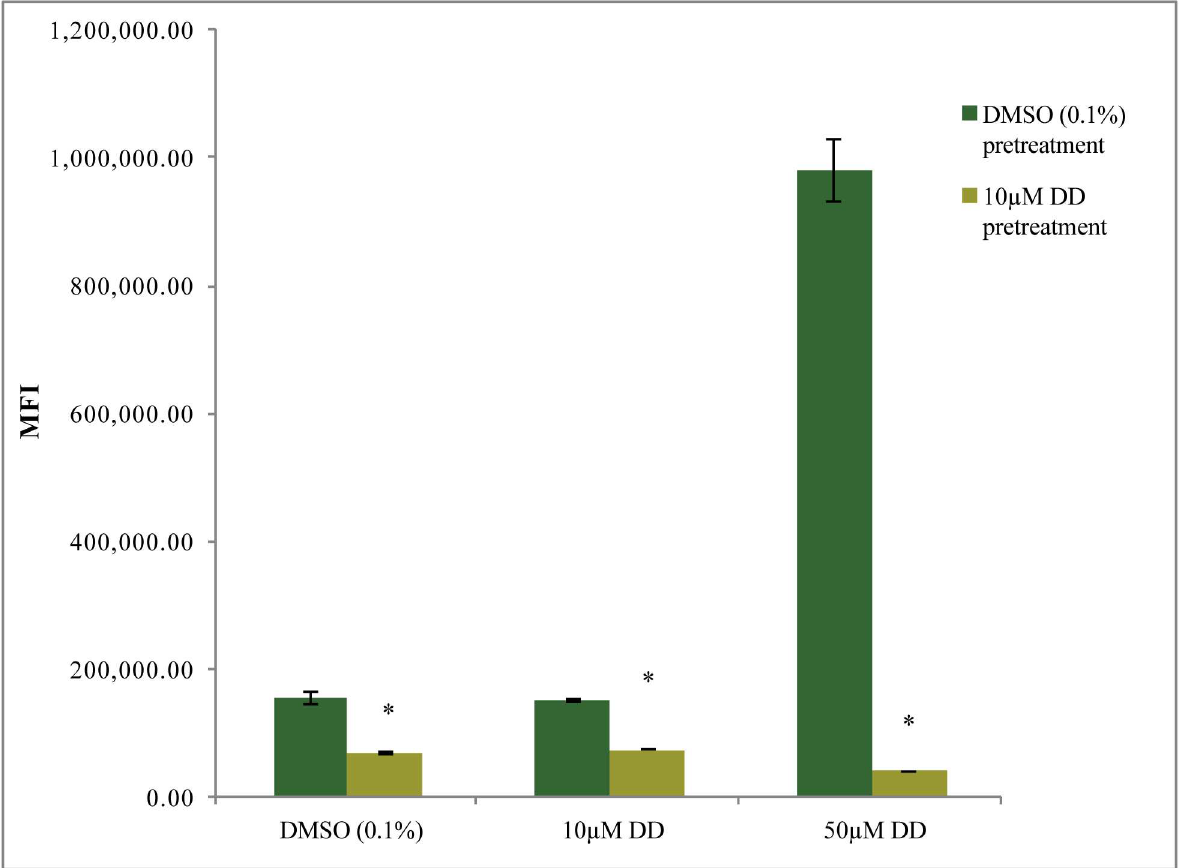
Fig 7. Effects of sublethal DD pretreatment on cell viability after 2 hr sublethal or lethal DD treatments. Cells were pretreatedwith either DMSO (0.1%) or DD (10 µ M) for 3 hr prior to subsequent additionof DMSO (0.1%), 10 µ M or 50 µ M DD dose for 2 hr. Cell accumulation of Sytox Green fluorescent dye was measuredby flow cytometry. MFI is Median Fluorescence Intensity. Error bars representstandard error. Changesin 10 µ M pretreated cells were significantwith respect to DMSO solvent control pretreatedcells, student’s T-test, * p < 0.05;n = 3 for DMSO and 10 µ M DD data set and n = 2 for 50 µ M DD data